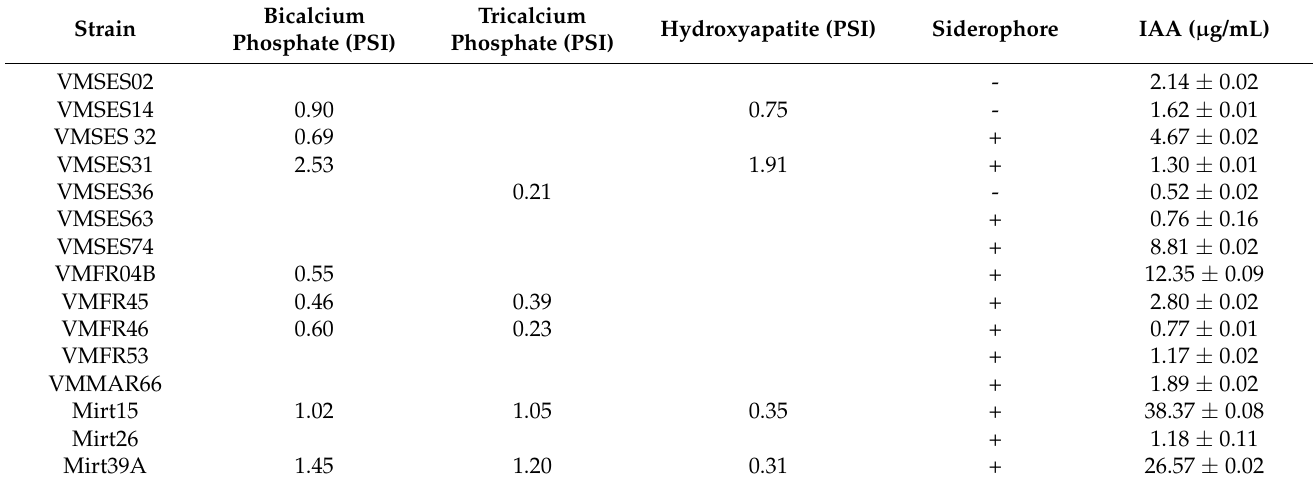
Table 1. PGP mechanisms of the selected strains and quantification of IAA by